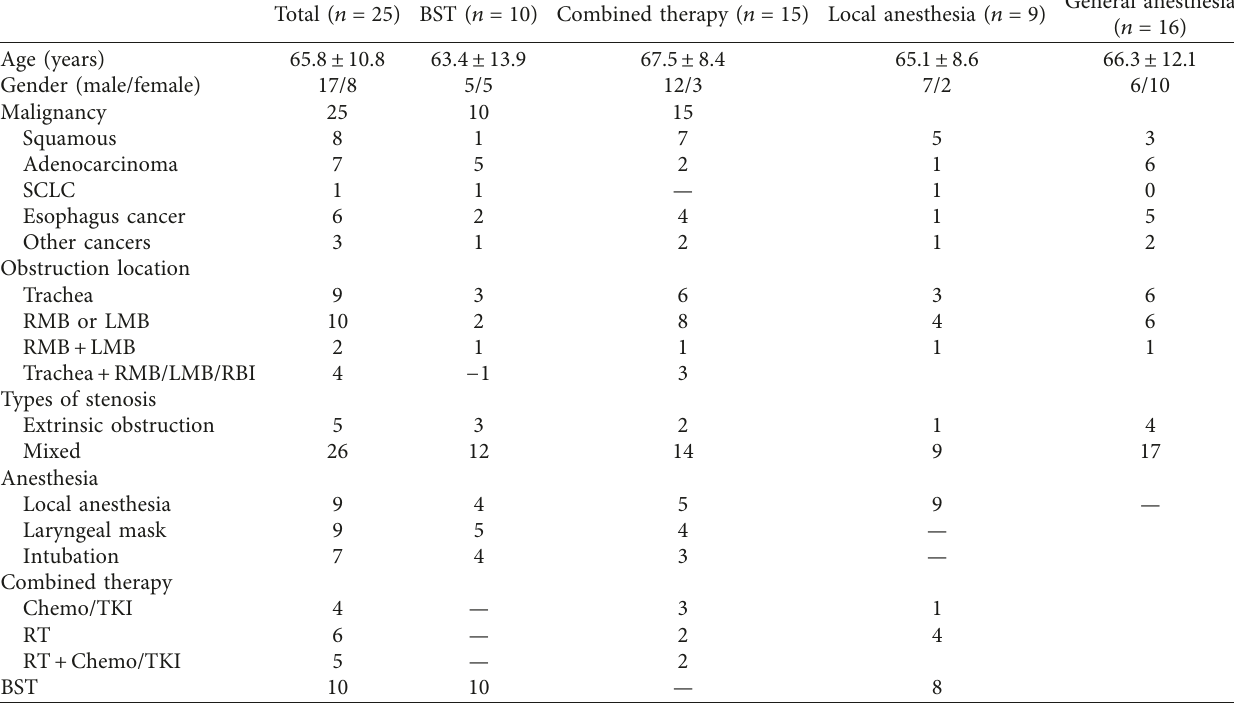
Table 1: Baseline characteristics of all patients.